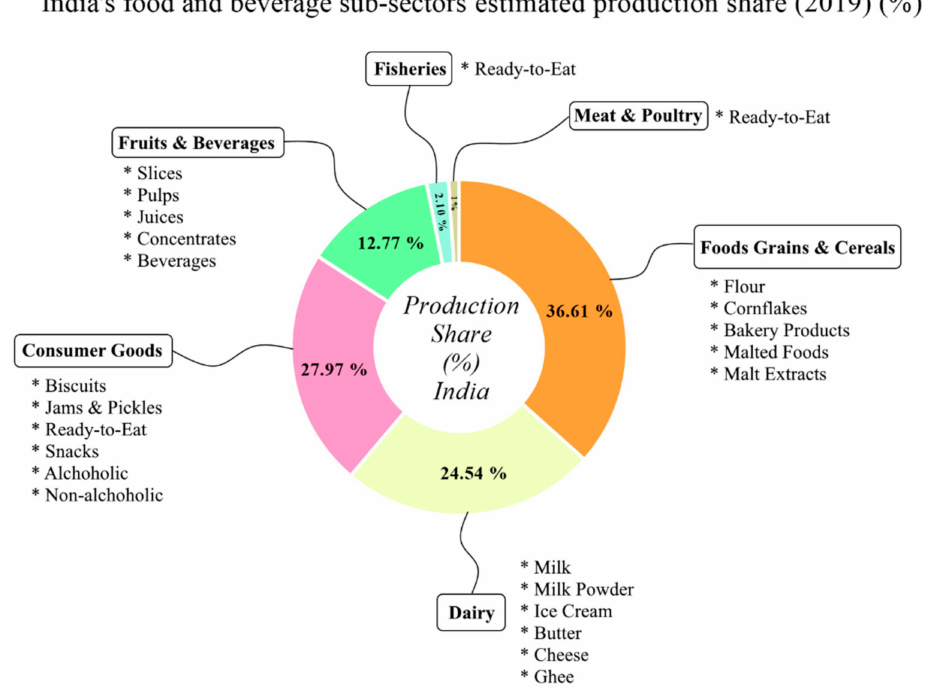
Figure 11. India’s food and beverage sub-sectors and estimated production share